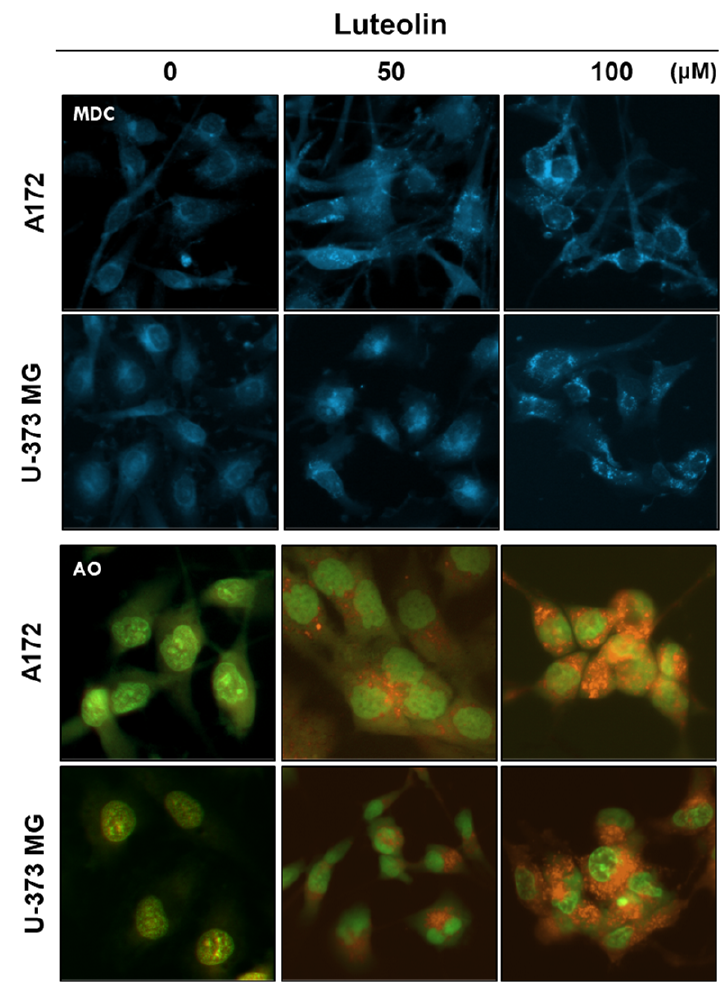
Figure 4. Detection of autophagic vacuoles in GBM cells using MDC and AO staining. Luteolin (50 and 100 µ M) treatment induced the autophagic vacuoles in the cytosol of the A172 and U-373MG cells, as revealed by MDC staining. Luteolin (50 and 100 µ M) increased the amount of AVOs (red fluorescence) in both GBM cells, as revealed by AO